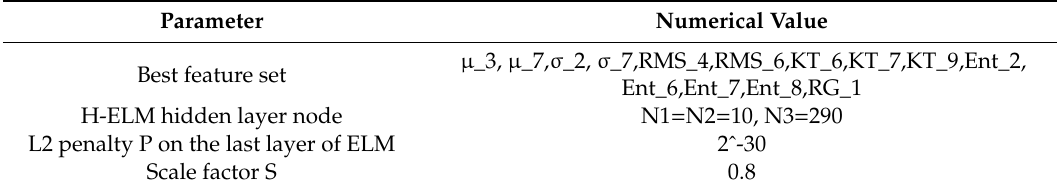
Table 7. The H-ELM algorithm parameter setting.